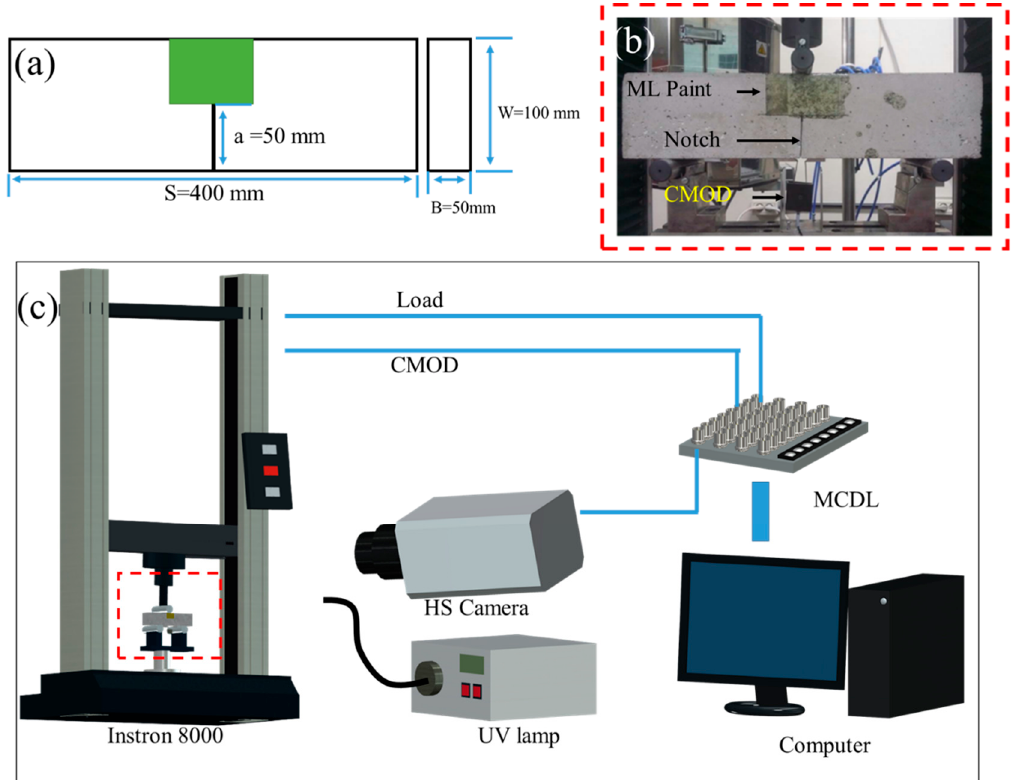
Figure 1. ( a ) Schematic diagram of a single-edge notched bend (SENB) specimen showing its dimensions with ML paint (green patch). ( b ) Real image of MC with ML paint applied to the surface ahead of the notch and a crack mouth opening displacement (CMOD) gauge attached to its notch. ( c ) Schematic diagram of the experimental setup illustrating the Instron 8000, UV lamp, high-speed camera, multichannel data link (MCDL), and computer that were used in the experiment. Table 1. The proportion of materials used in the specimens.